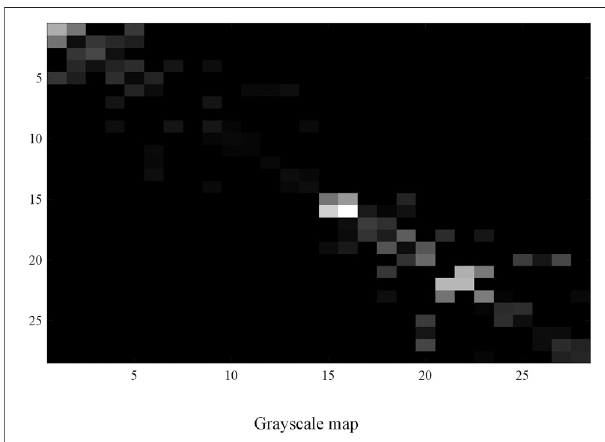
FIGURE 5 | The grayscale map is drawn from the original sample data.